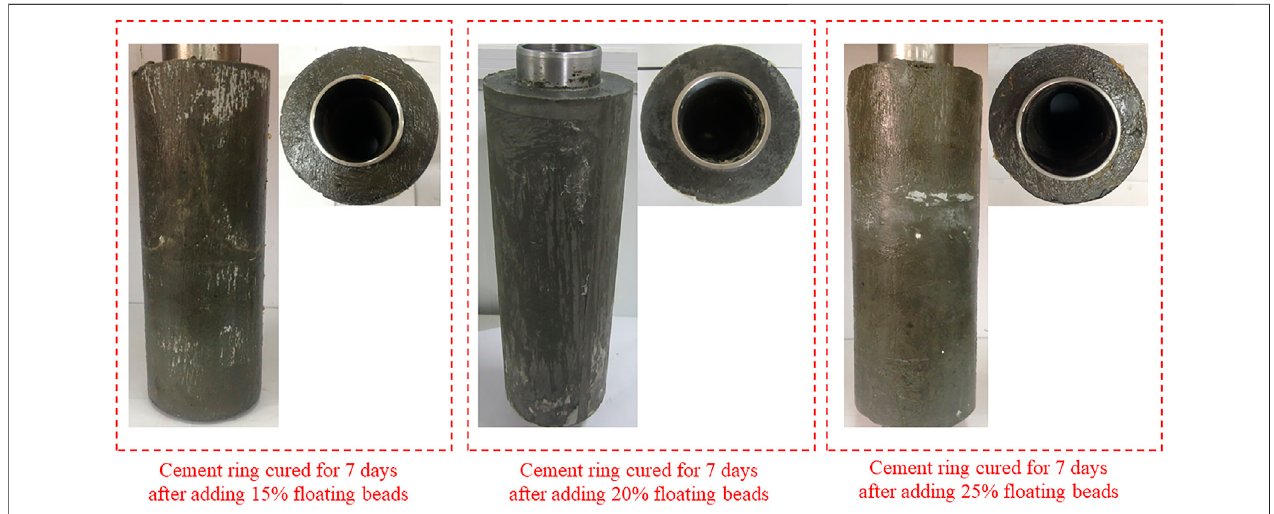
FIGURE 6 | Macro-morphology of cement rings with different amounts of fl oating beads after curing at 60 ° C for 7 days.